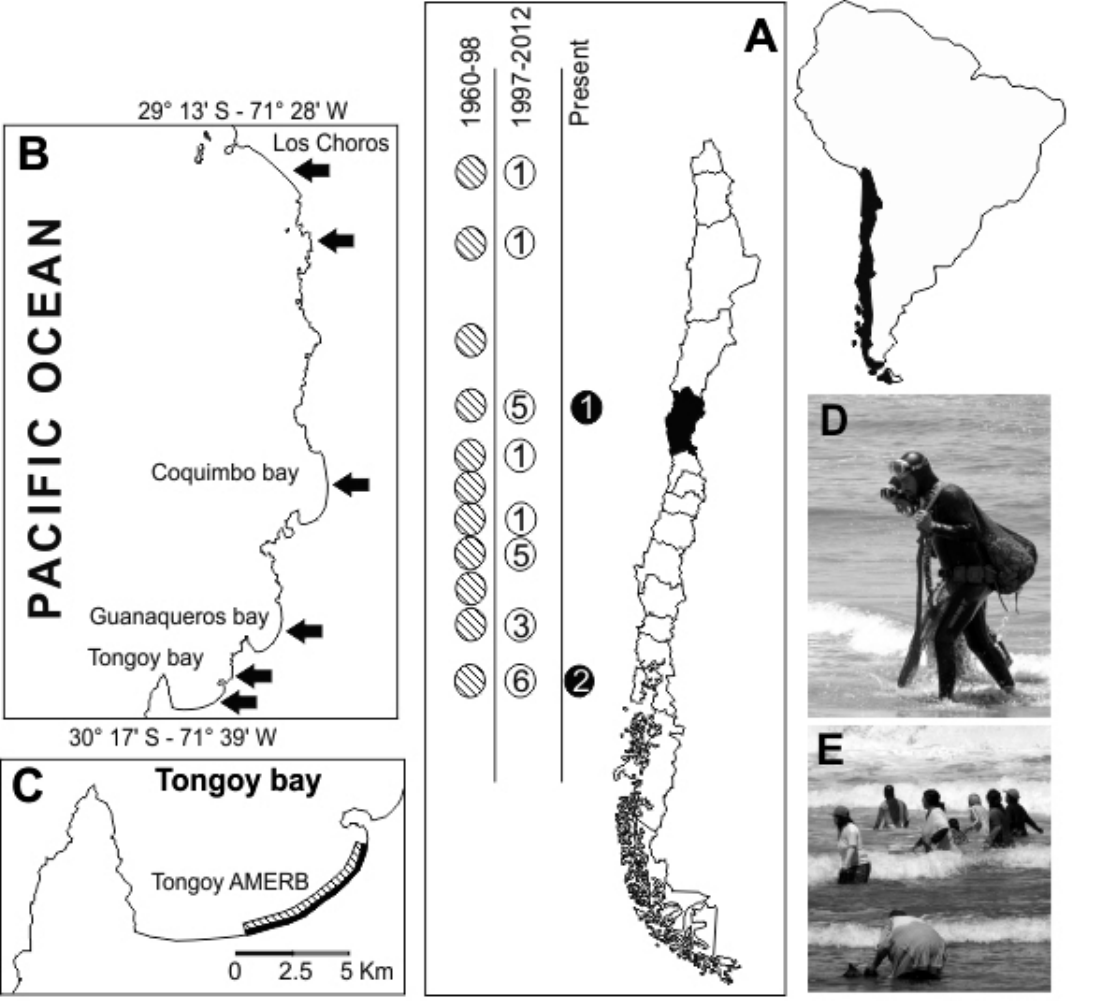
Fig. 1 . Study site, (A) Circle with striped pattern represents the administrative region in Chile (see Chile map) in which a surf clam fishery was developed in the period 1960-1998. The white circles with numbers represent the administrative region in which surf clam AMERBs were requested, the numbers represent the number of AMERBs granted. The black circle represents the AMERBs that are currently functioning. The black zone in the map represents the general location of the study site. (B) Bay system of Coquimbo region, main sandy beaches are shown with black circles. (C) Location of Tongoy AMERB, the black polygon represents